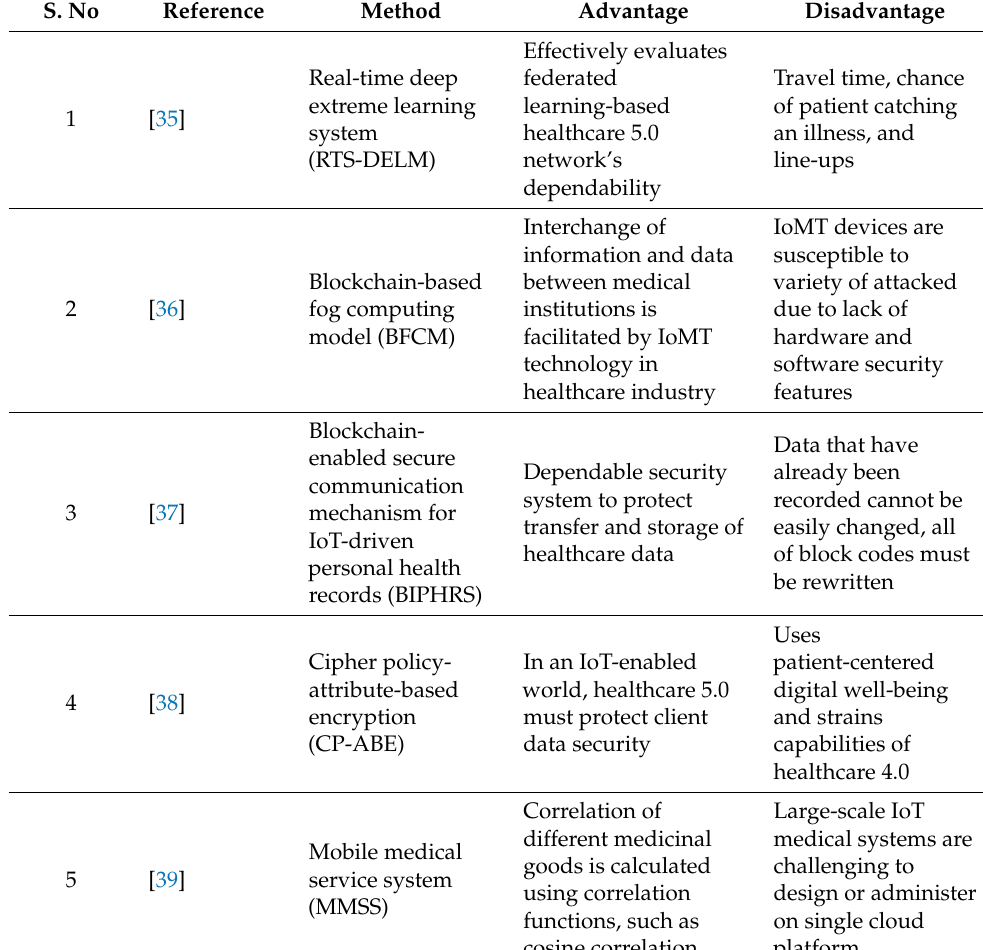
Table 1. Summary of existing